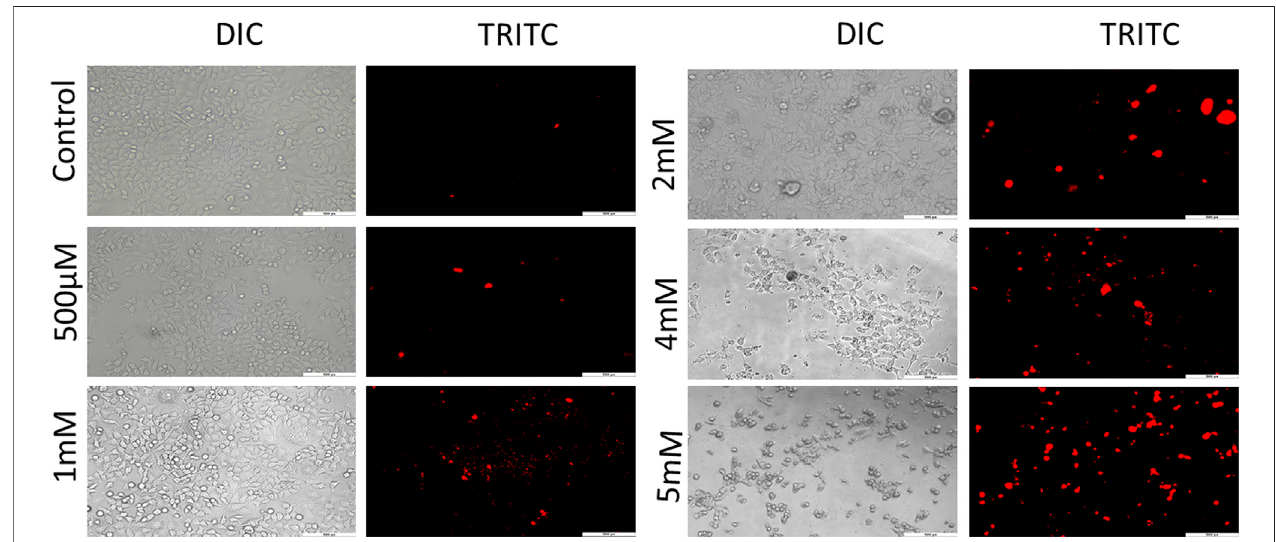
FIGURE 2 | PI staining for live/dead exclusion. HCT116 cells treated with GIV show higher PI positivity, an indication of compromised cell membranes. The cells were imaged at × 20 magni fi cation.